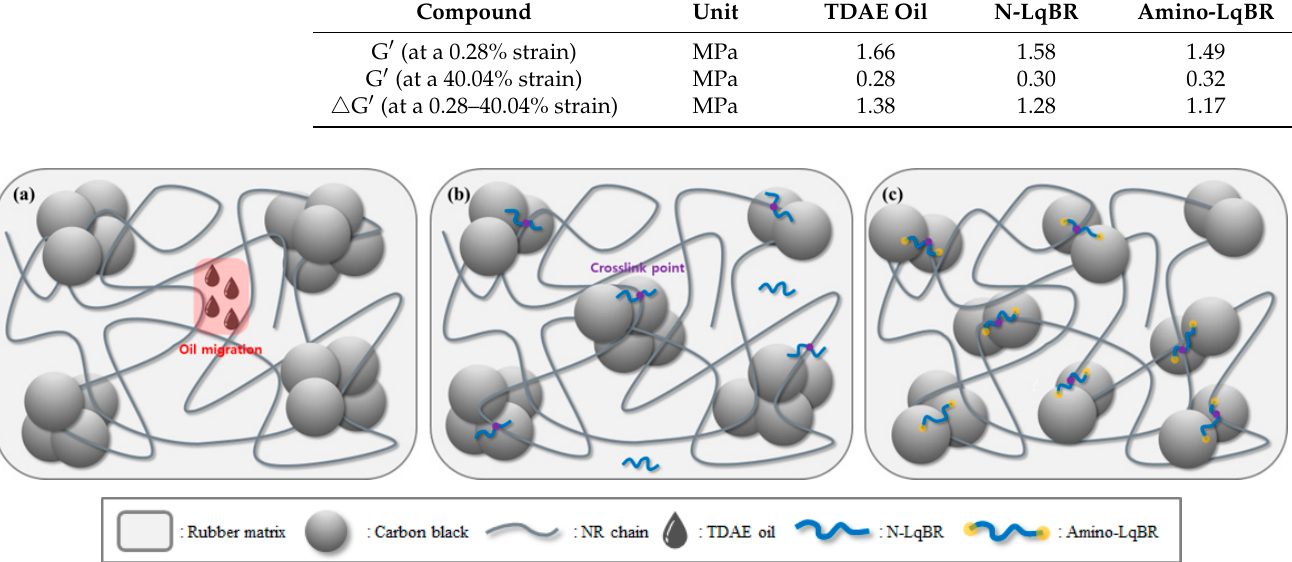
Figure 5. Proposed carbon black dispersion mechanism in the rubber matrix; ( a ): TDAE oil, ( b ): N- LqBR, ( c ): amino-LqBR.